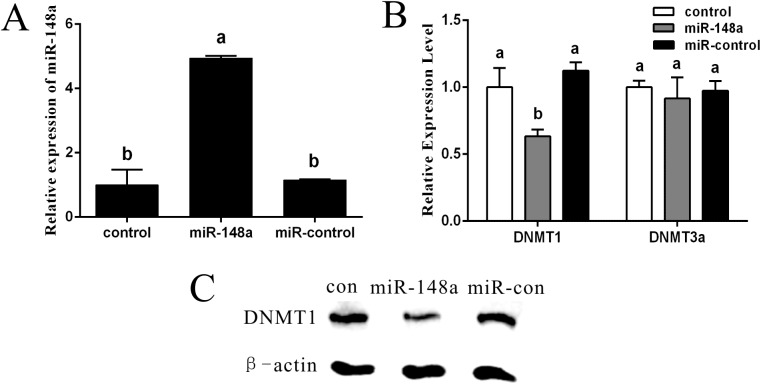
miR-148a inhibited DNMT1expression.(A) miR-148a expression was increased in PFFs of overexpressing miRNA-148a. (B) DNMT1 expression was decreased in PFFs of overexpressing miRNA-148a. DNMT3a expression has no difference in PFFs of overexpressing miRNA-148a compared with control group. (C) Western blot assays confirmed that DNMT1 expression were downregulated by in PFFs of over-expression miR-148a. Values with different superscript letters (a, b) within groups indicate significant difference (p < 0.05).